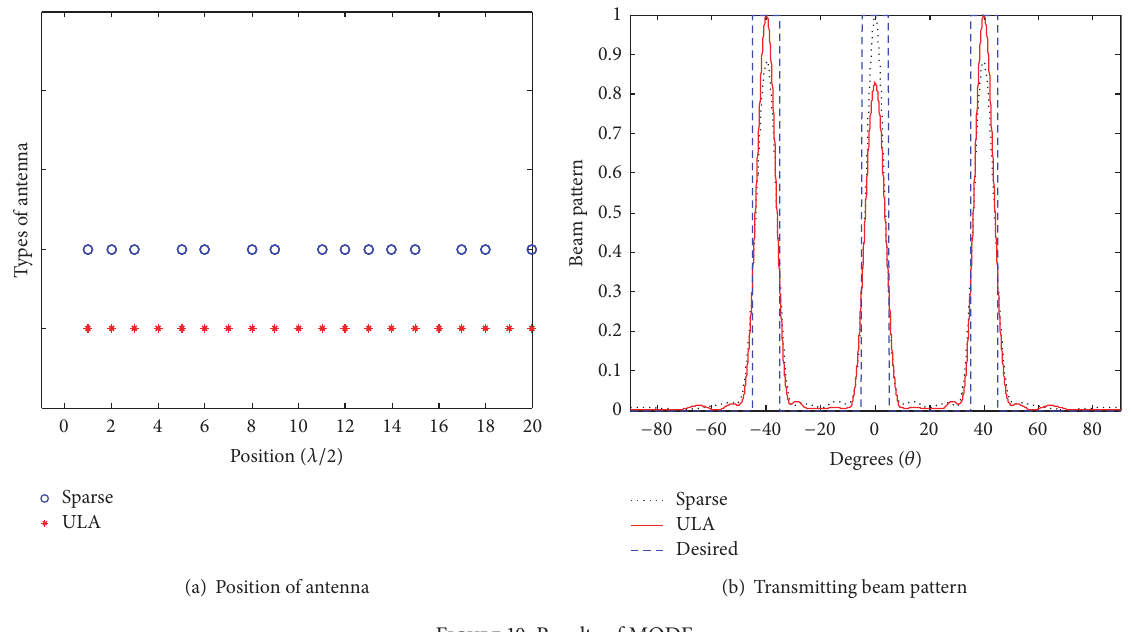
Figure 10: Results of